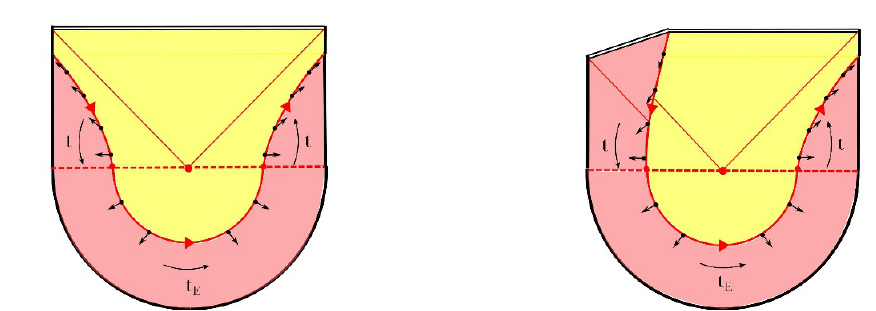
Figure 3 . Schematic diagram of the bubble nucleation when the internal mass is non-zero. After the nucleation of the static shell any small perturbation would cause it to either expand or collapse. Left: the shells in both sides expand. Right: the shell in one side collapses while the other expands. We used absorptive AdS boundary conditions for simplicity.